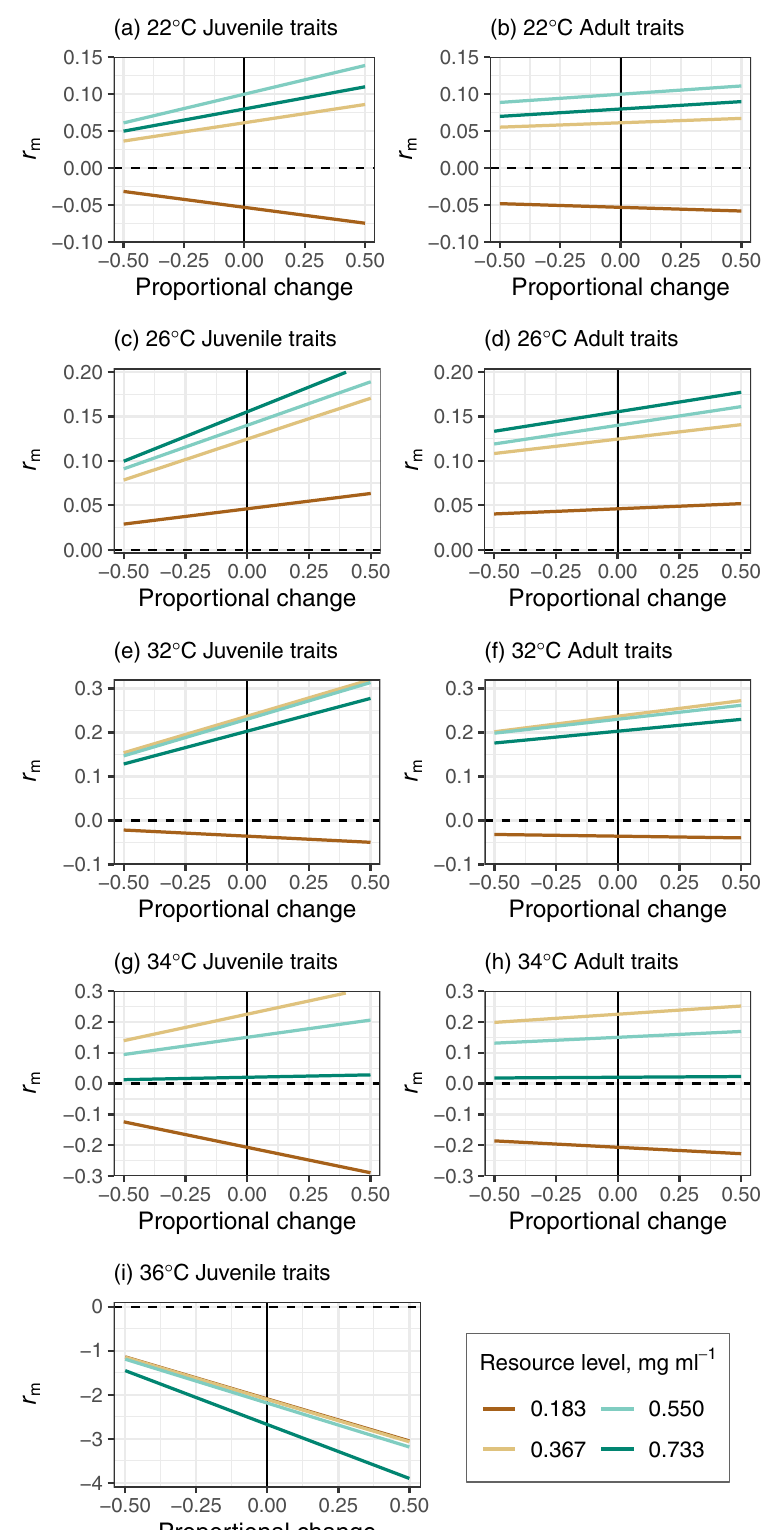
Fig. 3 Sensitivity of Ae. aegypti population fi tness ( r m ) to proportional changes in juvenile and adult traits by temperature across resource levels. Juvenile survival and development contributed more substantially to r m , as relatively small changes in the summed matrix elements for these traits would result in relatively large changes in r m . Sensitivity of r m to adult traits (survival, fecundity) was much weaker compared to sensitivity to juvenile traits. Juvenile traits are shown in ( a ), ( c ), ( e ), ( g ), and ( i ). Adult traits are shown in ( b ), ( d ), ( f ), and ( h ). Source data are in Supplementary Data